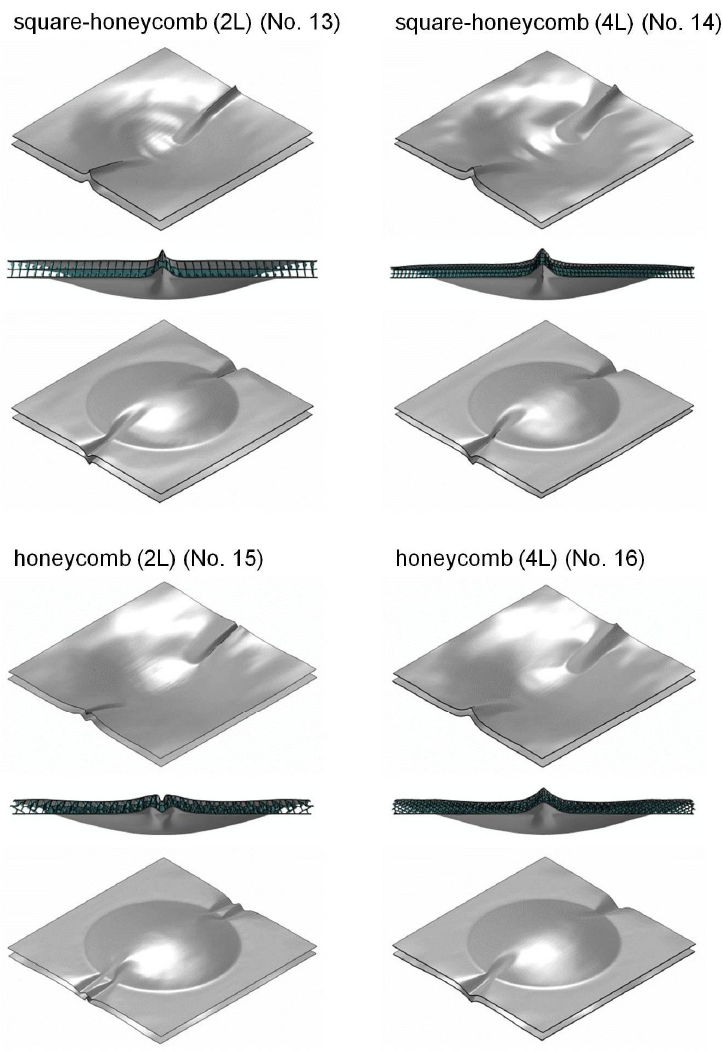
Figure A5. Deformation states of the top and bottom sides for prismatic, multi-layered, non-auxetic cores No. 13–16 subjected to air-blast loading (t = 0.6 ms).